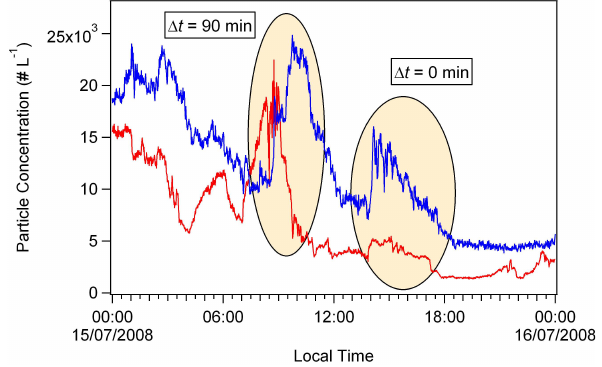
Fig. 9. Time-series of submicron particle concentrations above canopy from the APS (red trace) and in the trunk space from the OPC (blue trace) illustrating a relationship between the measure- ments at the two sites and the variation in delay time ( 1t ).